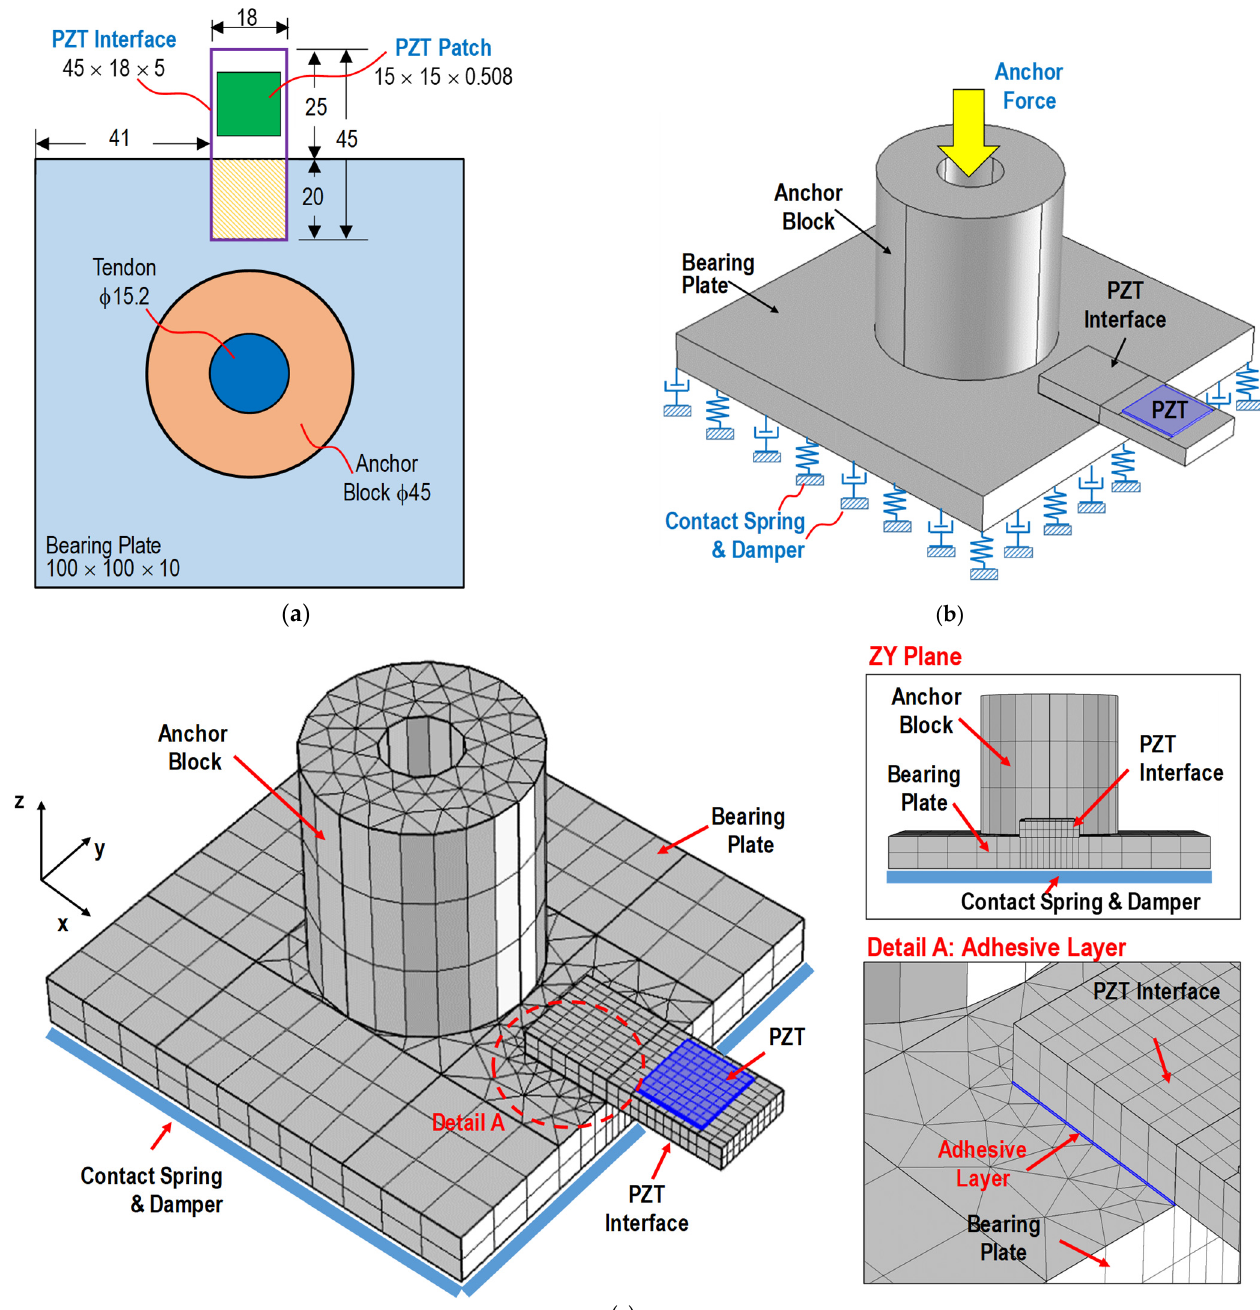
Figure 4. Finite element modelling of the PZT interface-anchorage system. ( a ) Geometric parameters (unit: mm); ( b ) Equivalent finite element model; ( c ) Meshed finite element model. Table 1. Mechanical properties of the aluminum interface and the steel anchorage.